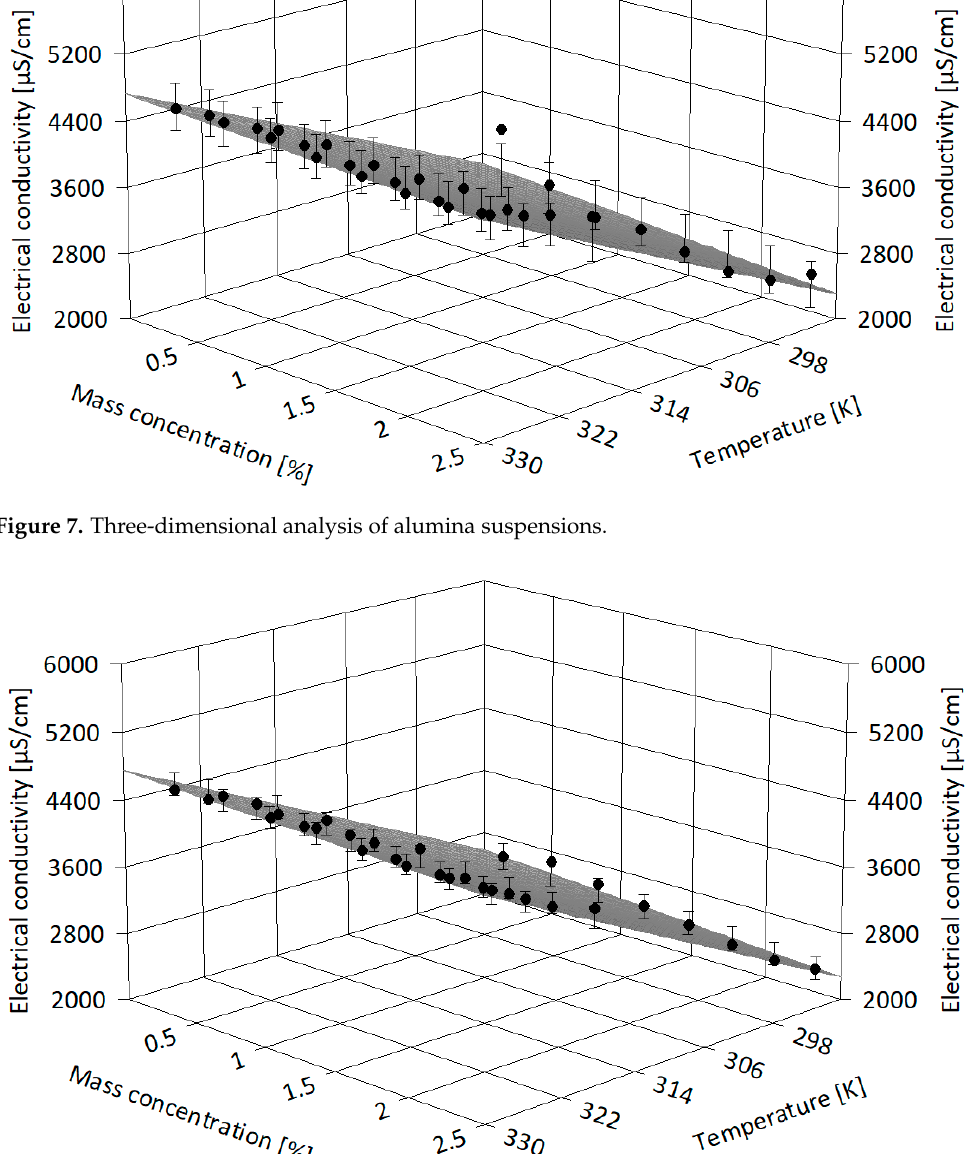
-For ZnO suspensions: